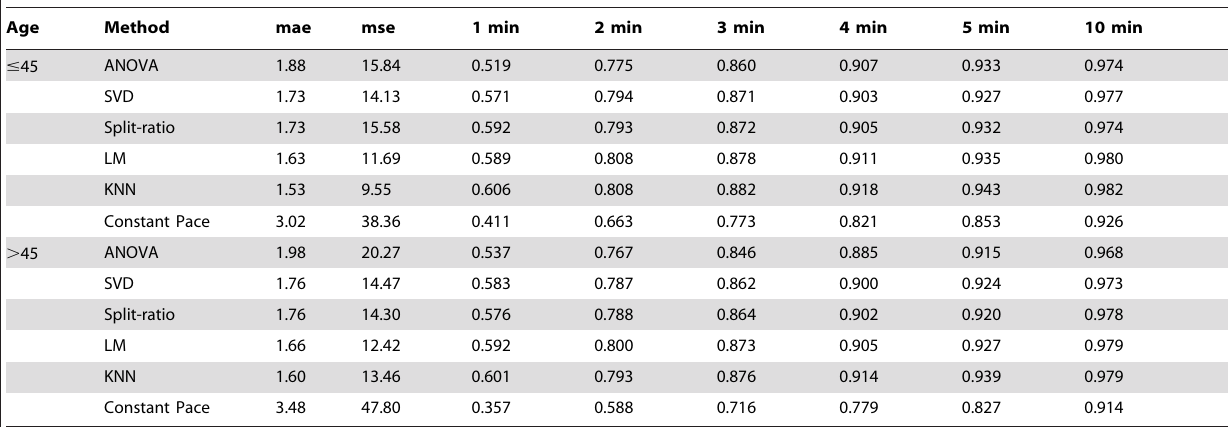
Table 4. Results by age.